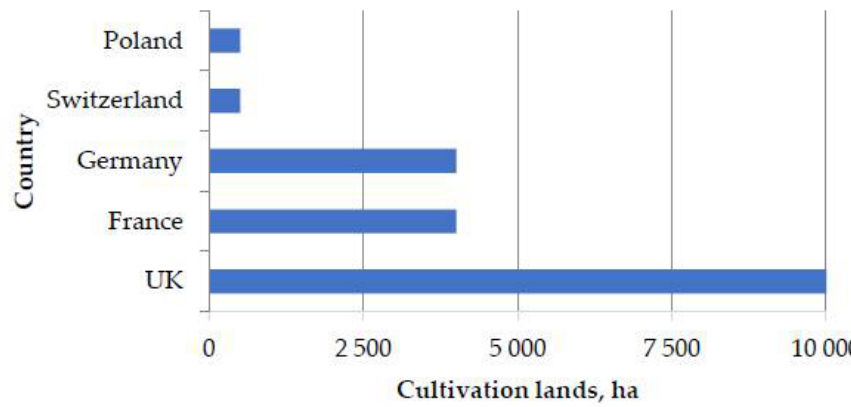
Figure 1. Distribution of the lands under miscanthus cultivation by EU countries (the figure is based on the data from [20]).